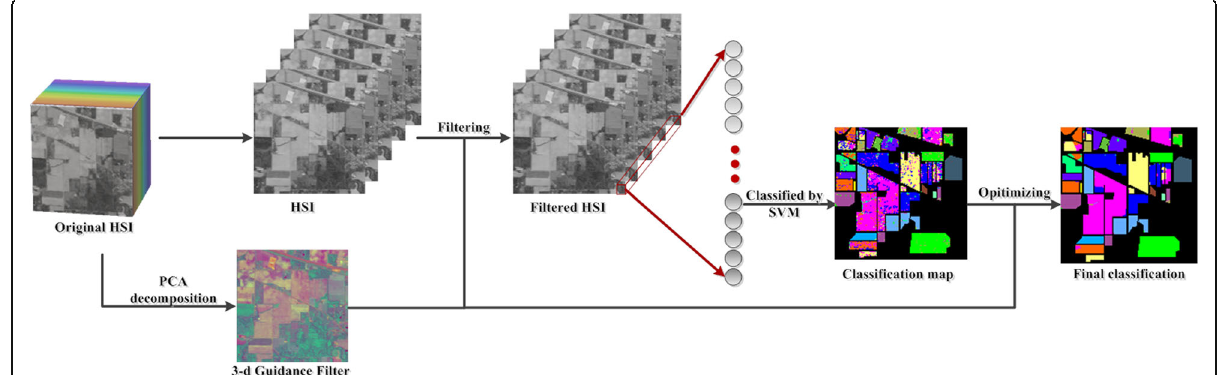
Fig. 1 Framework of HSI classification by the proposed method. Original HSI was used to get the guidance image (filter) and decomposed HSI by PCA firstly. Then, decomposed HSI was filtered by a guidance filter. Subsequently, a SVM classifier was adopted to get the classification map. Finally, edge preserving filter was applied to optimize the classification map